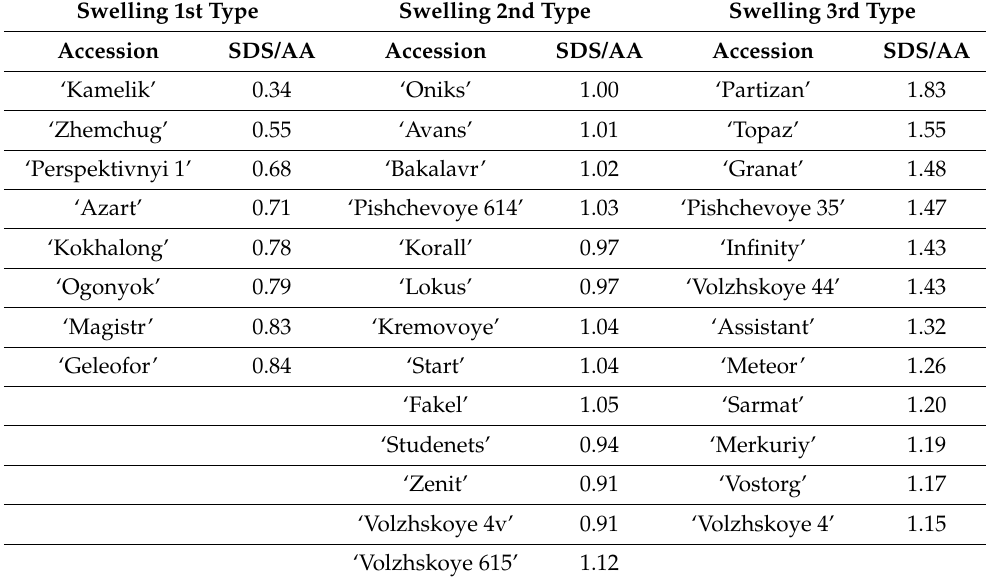
Table 3. Differentiation of grain sorghum genotypes according to the type of milled grain swelling.